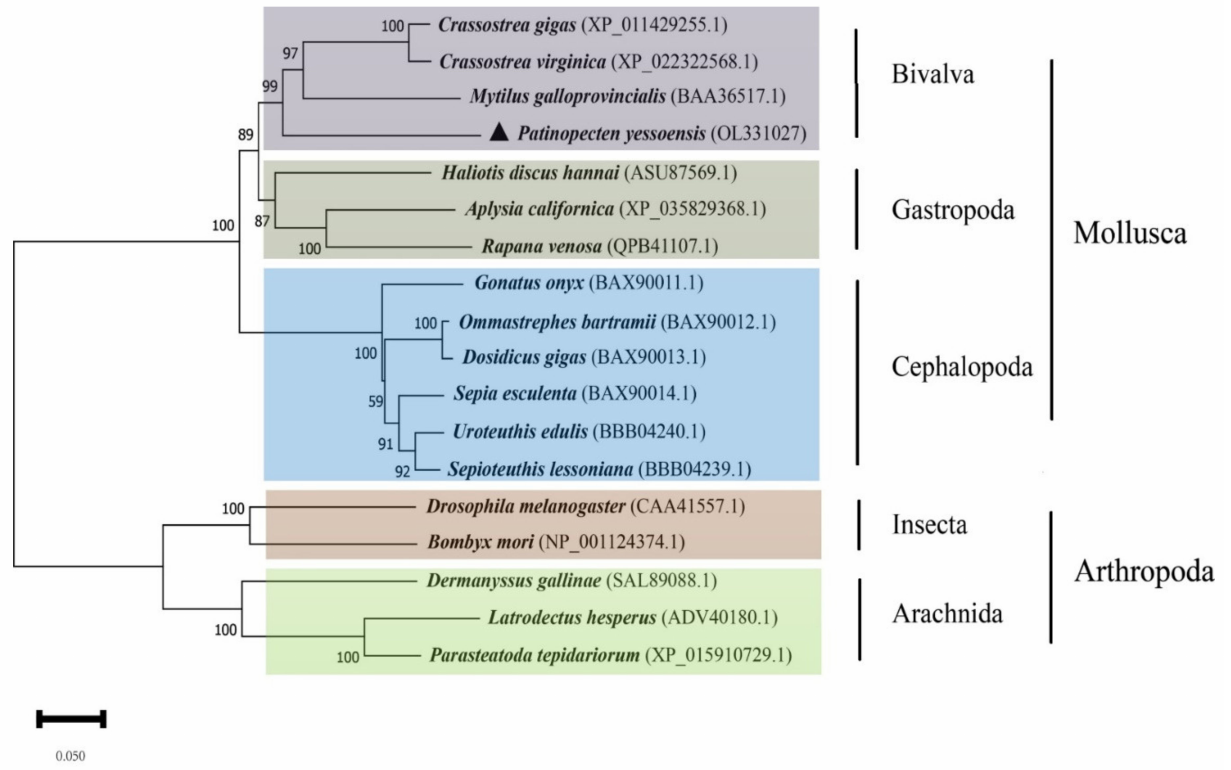
Figure 5. A phylogenetic analysis of paramyosin was constructed based on 18 different invertebrate species. The names of species, and their accession numbers, are indicated in the phylogenetic